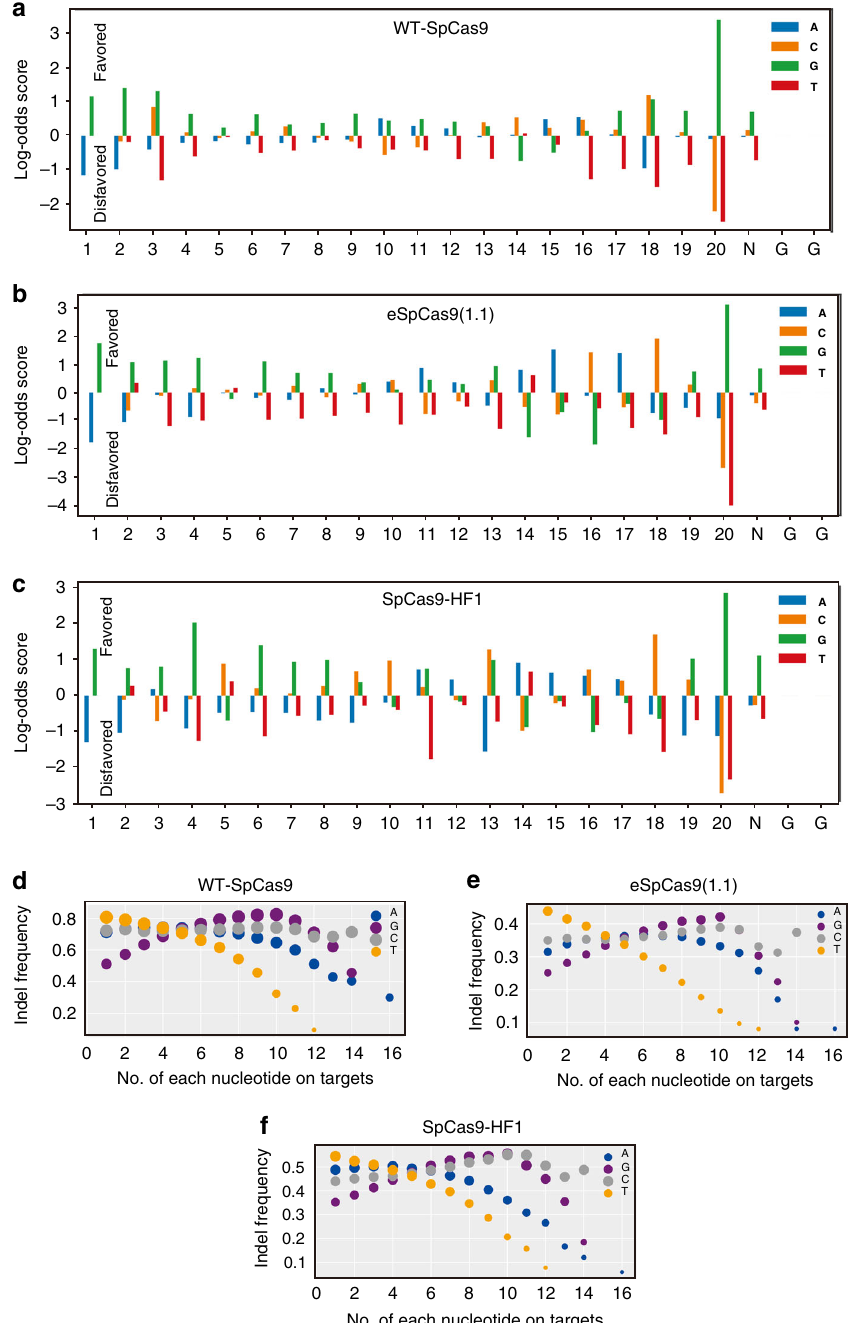
Fig. 4 In fl uence of nucleotide composition on gRNA activity. a – c The position-dependent nucleotide composition of the highest 25% active gRNAs versus lowest 25% active gRNAs. Bars showed log-odds scores of nucleotide frequency for each position. The numbers below indicated the position of the nucleotides on-target DNA. d – f The association of each nucleotide number with gRNA activity. The size of the circles indicated indel